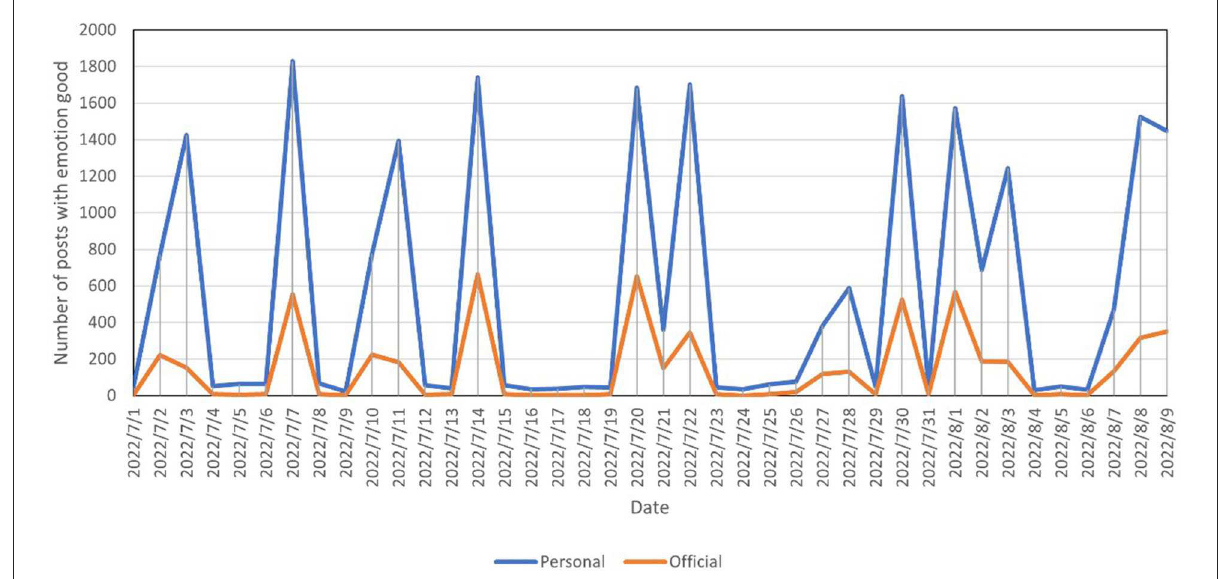
FIGURE2 Number of blogs with the emotion of good posted by official and personal users.